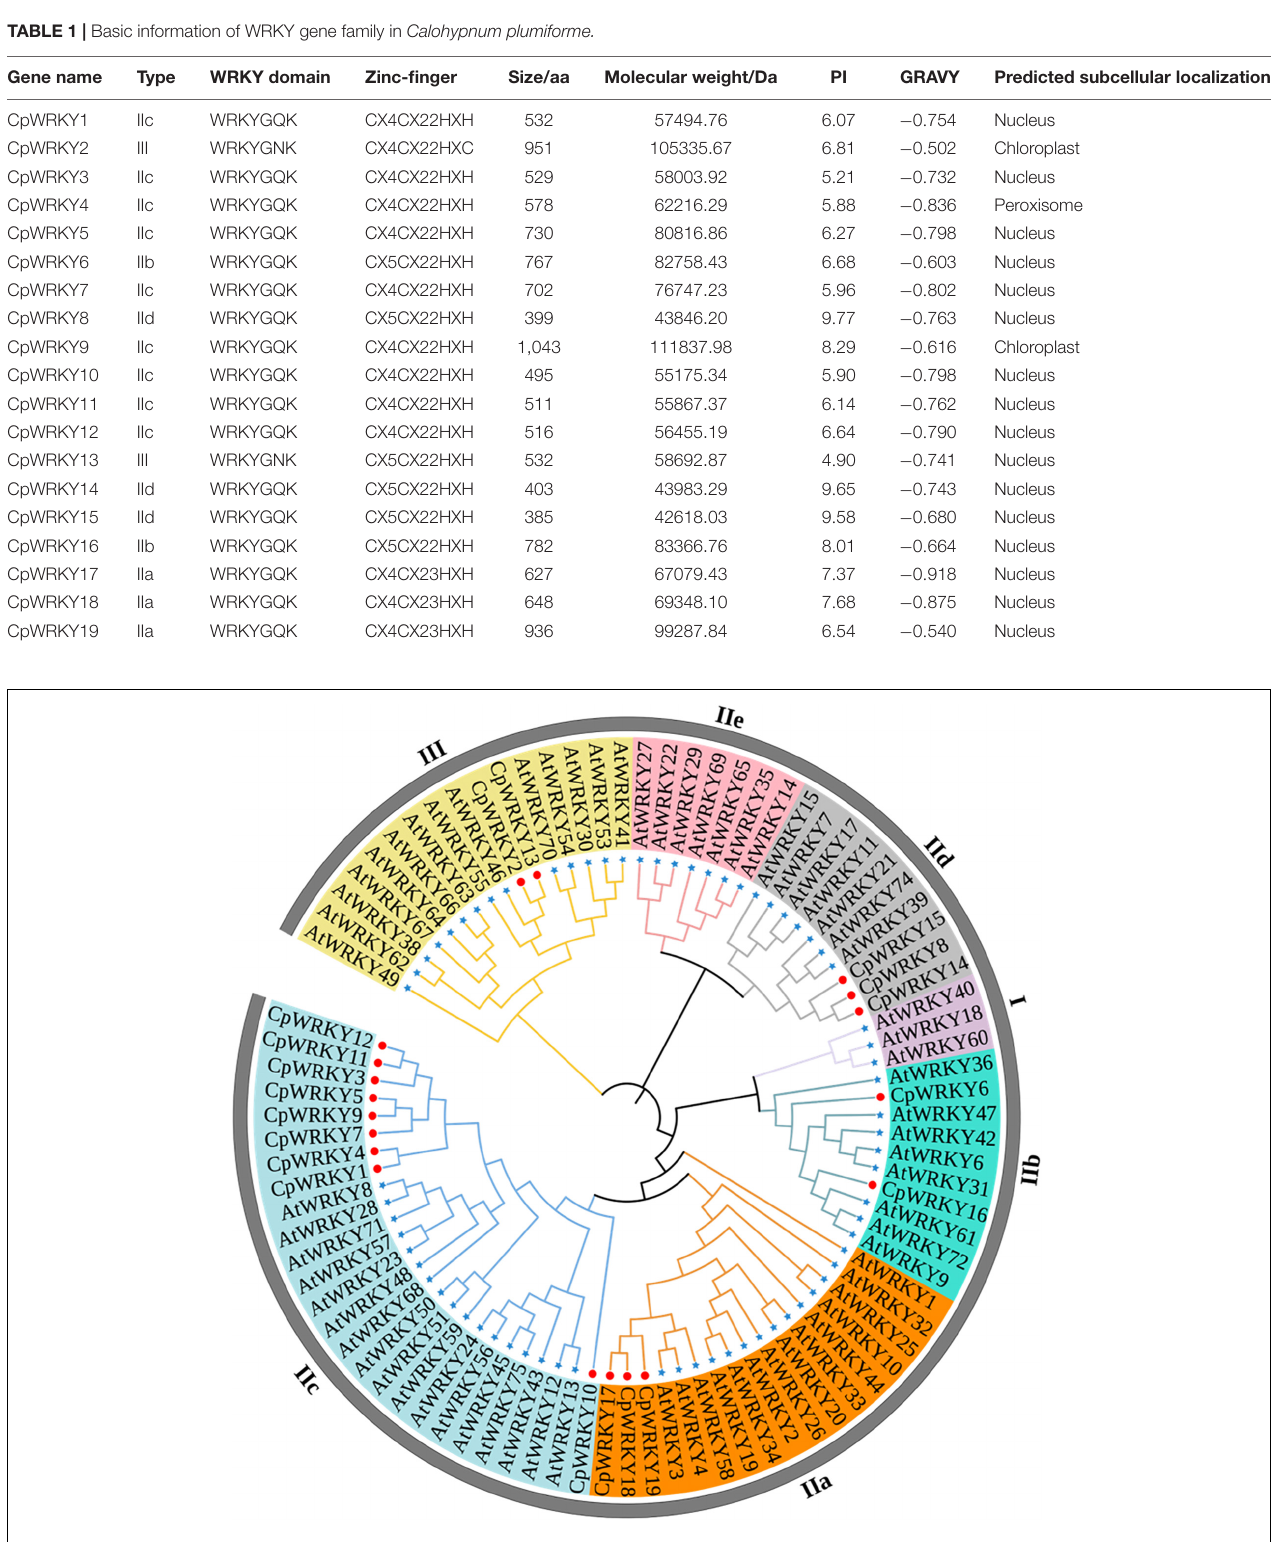
FIGURE 1 | Phylogenetic analysis of WRKY proteins in Calohypnum plumiforme and Arabidopsis thaliana. The WRKY domain protein sequences of C. plumiforme and A. thaliana were aligned with Clustal W, and the phylogenetic tree was constructed using MEGA 6 based on the neighbor-joining (NJ) method. The bootstrap value was 1,000 replicates. The proteins were classified into three groups and five subgroups. The colored branches indicate the different subgroups.